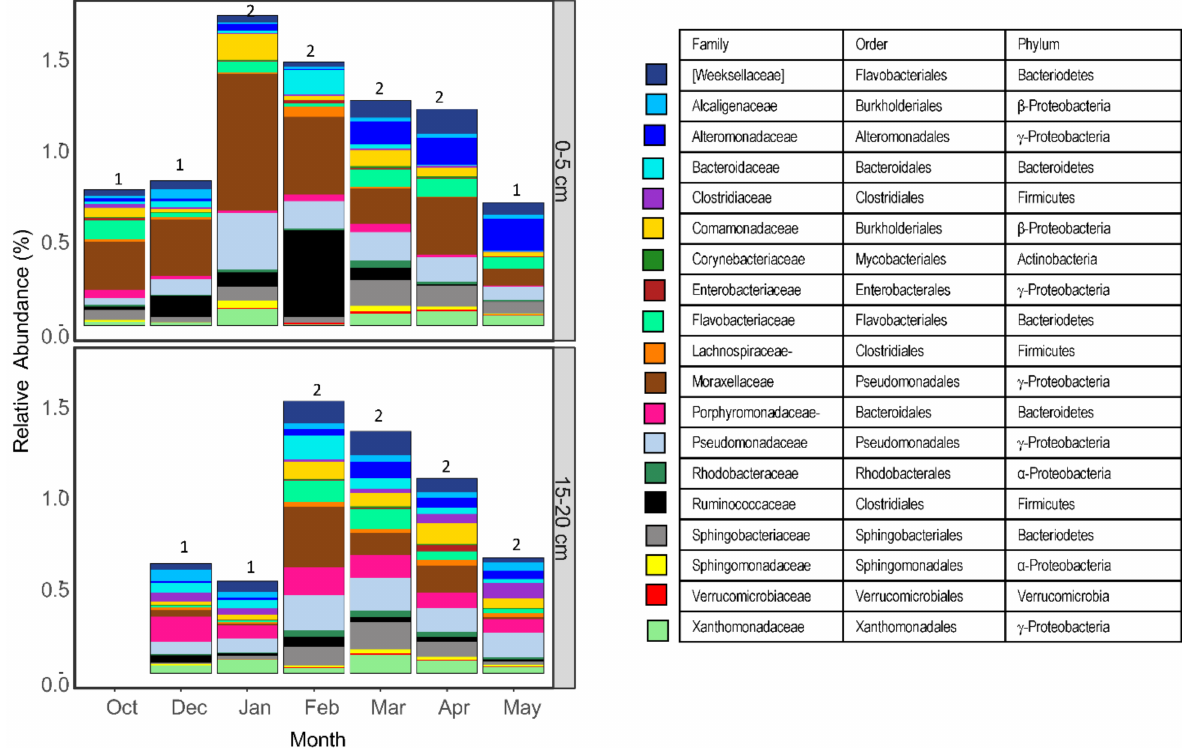
Figure 3. Relative abundance of bacterial taxa (out of 220) that are represented in all 100% samples split by depth and month at Farm C. The first date (October) is just the top layer because it is the beginning of the pack building. Sample size is illustrated above each bar. Microbiome varied by time (pseudo- F = 1.57, p = 0.002) and depth (pseudo- F = 1.55, p =